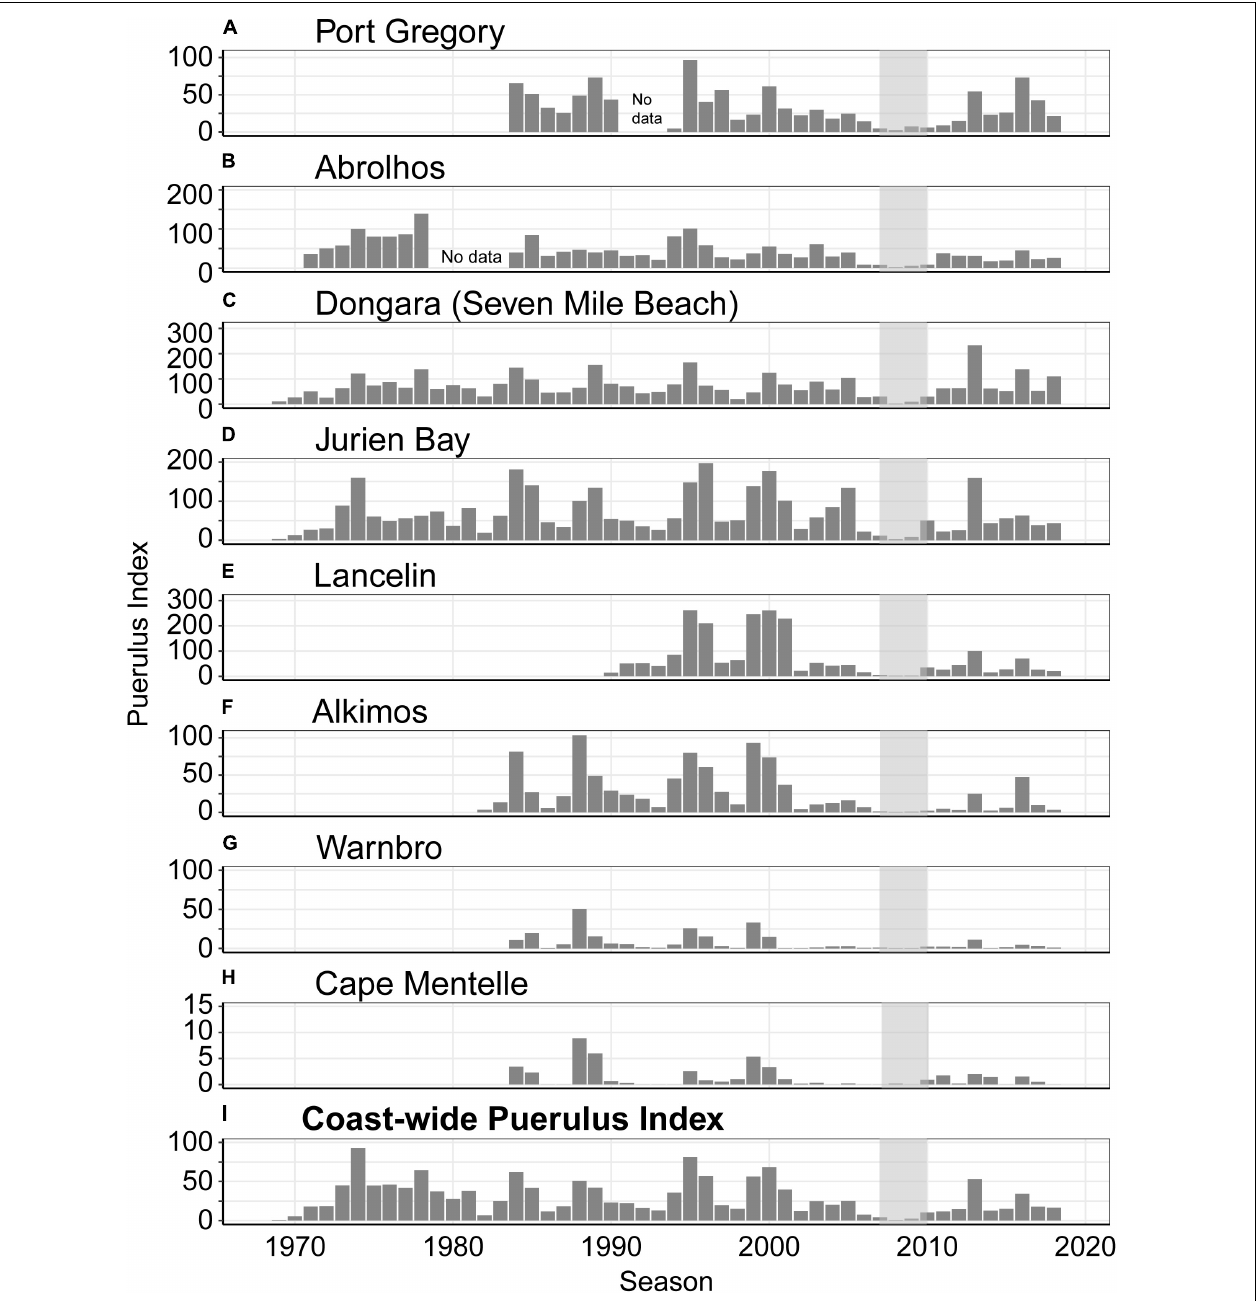
FIGURE 2 | Annual Puerulus Index (PI) at all survey sites currently in use. In order of latitude from north to south (A) Port Gregory, (B) Abrolhos, (C) Dongara (Seven Mile Beach), (D) Jurien Bay, (E) Lancelin, (F) Alkimos, (G) Warnbro, and (H) Cape Mentelle. The fishery-wide PI (I) is calculated as a mean of all 8 sites. The gray shading indicates the period of low settlement index which occurred over the whole fishery.